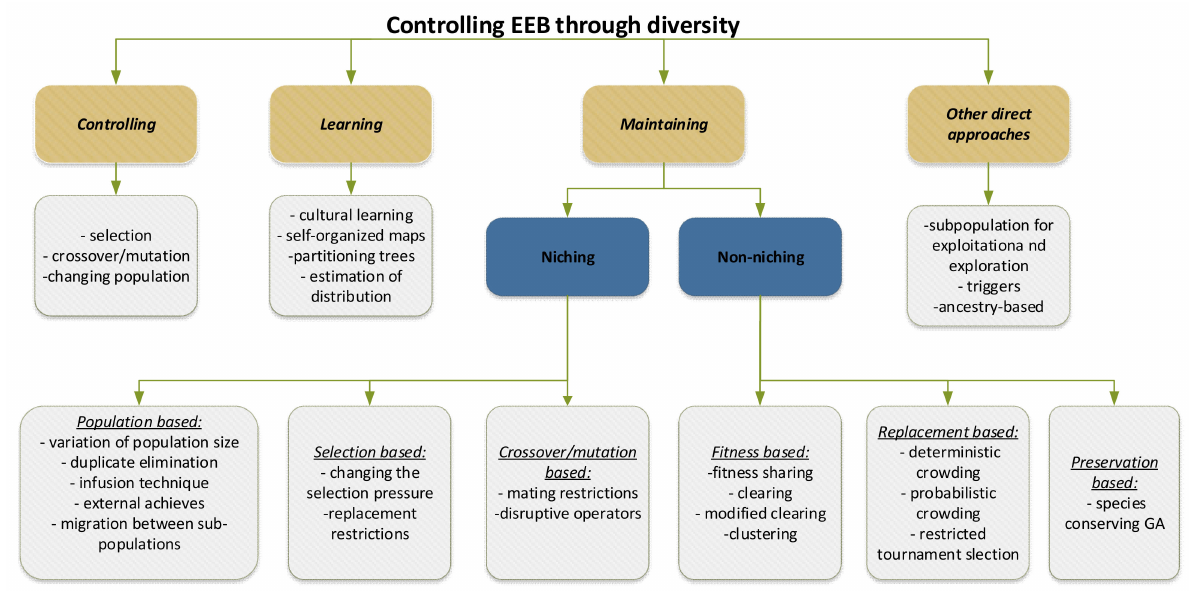
Figure 2. Mechanisms used to control the exploration–exploitation balance through diversity. Table 6 shows the different mechanisms for the EEB used by the initial versions of the algorithms presented in Section 3. The subsequent modifications performed to the base versions are not considered in this table. The following notations are used: C indicates the controlling mechanisms, L the learning approaches, OD are the other direct approaches and H. represents the hybrid techniques. Pop. represents the population-based techniques, Sel. the selection based, Crs. the crossover/mutation based, Fit. the fitness based, Rep . the replacement based and Pres. the preservation-based approaches. In Table 6, in each case a specific approach is encountered in the algorithm, an x is set in the corresponding